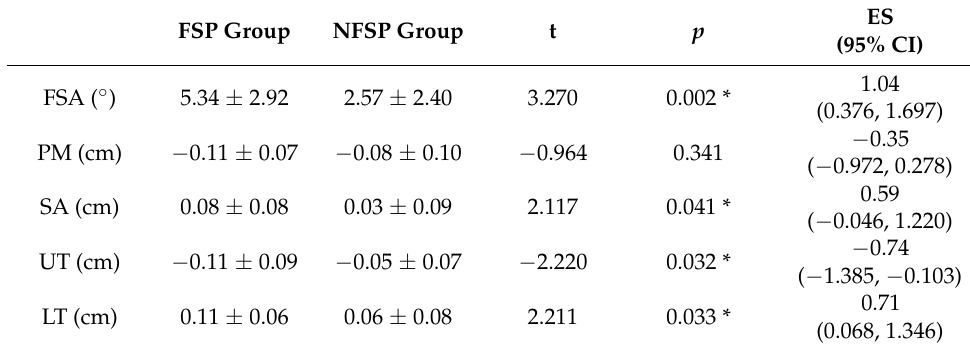
Table 3. The changes in the forward shoulder angle and muscle thickness between groups. FSP Group